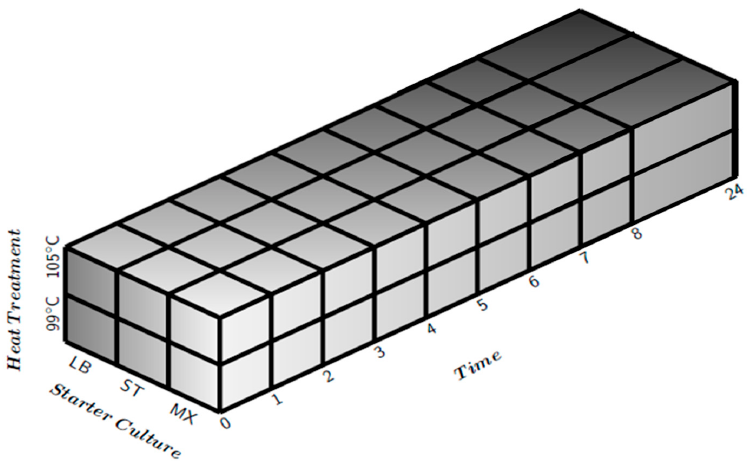
Figure 6. Illustration of the experimental design: it is a three-way factorial design with two di ff erent heat treatments (105 ◦ C and 99 ◦ C), three di ff erent starter cultures (LB, ST and MX) and ten di ff erent fermentation times (0, 1, 2, 3, 4, 5, 6, 7, 8 and 24 h). All measurements were